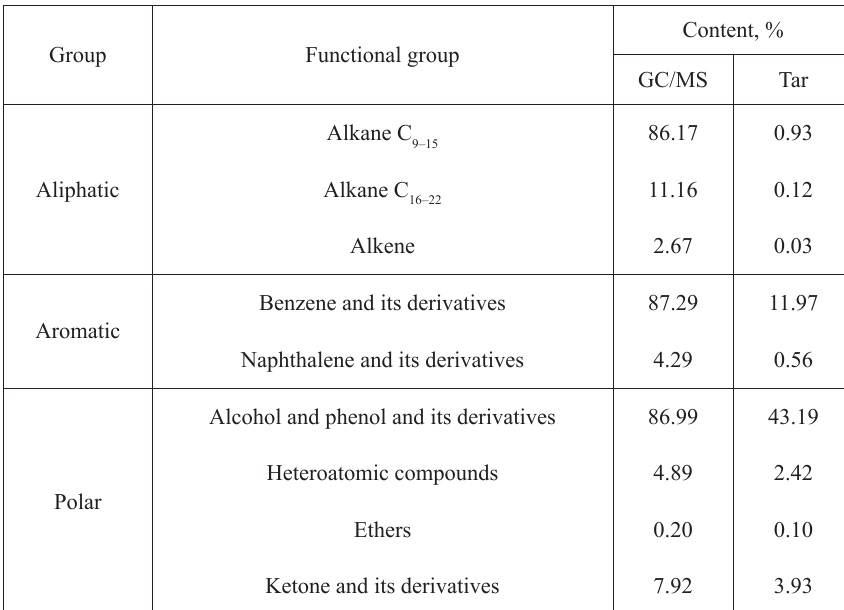
Table 6. The results of GC/MS analysis of the light distillation fraction of pyrolysis